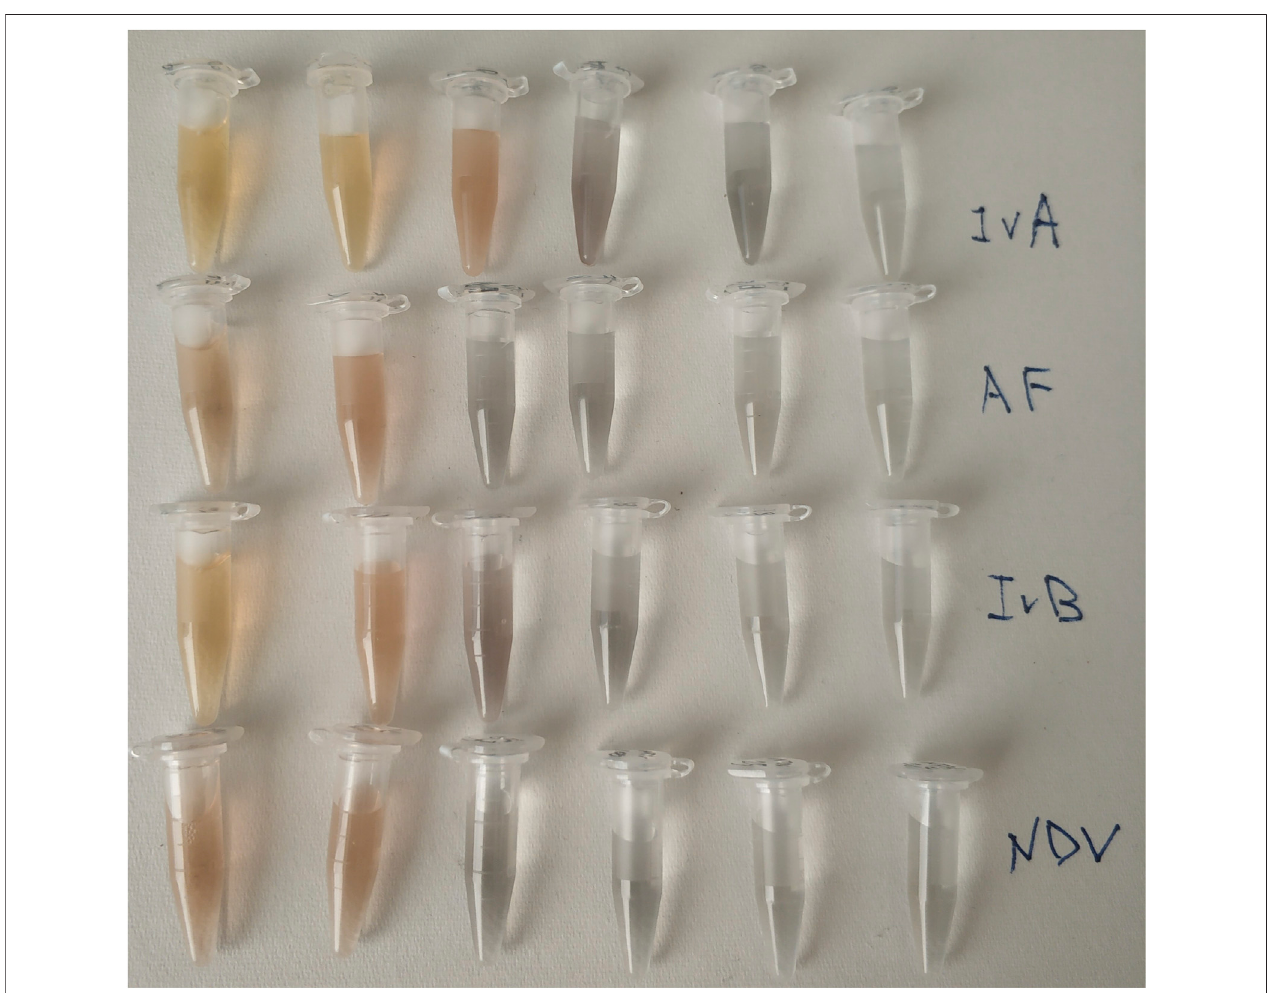
FIGURE2| Colorchangesin theconcentrated solutions ofviruses.IvA – in fl uenza Avirus — from leftto right — 2 · 10 10 VP/ml; 5 · 10 9 VP/ml; 1.4 · 10 9 VP/ml; 5 · 10 8 VP/ ml; 1.2 · 10 8 VP/ml; and 1.2 10 7 VP/ml. AF – allantoic fl uid – dilutions are the same as for the in fl uenza A virus. IvB – in fl uenza B virus — from left to right — 8 · 10 10 VP/ml; 2 · 10 10 VP/ml; 5 · 10 9 VP/ml; 2 · 10 9 VP/ml; 5 · 10 8 VP/ml; and 5 · 10 7 VP/ml; NDV – Newcastle disease — from left to right — 4 · 10 10 VP/ml; 1.0 · 10 10 VP/ml; 3 · 10 9